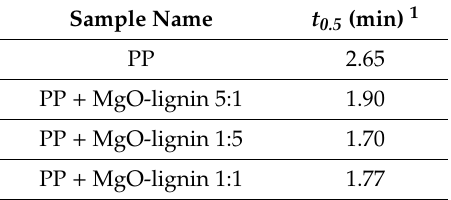
Figure 6. Crystal conversion rates for PP and composites. Table 5. Crystallization half-times of PP and its composites.